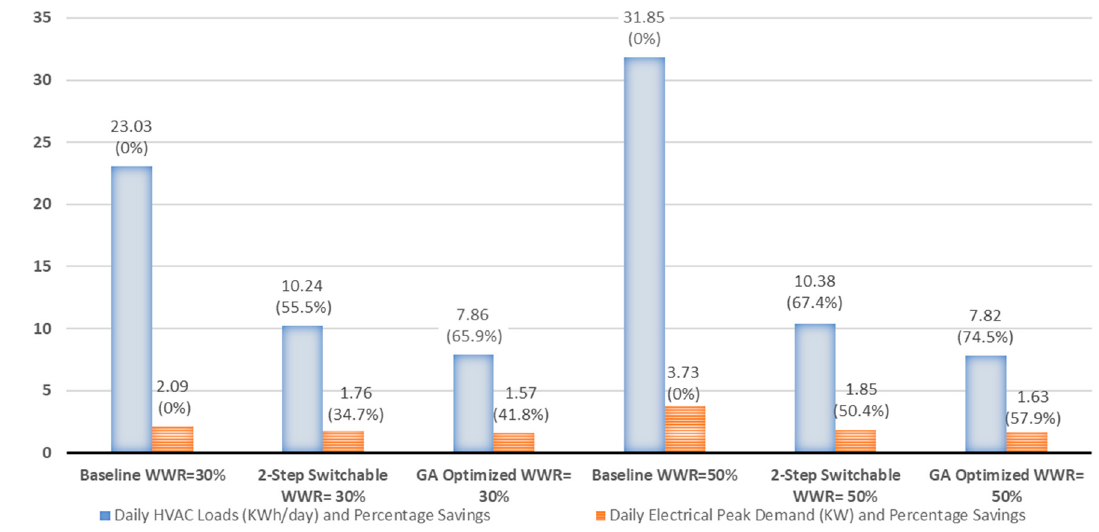
Figure 14. HVAC loads and electrical peak demand for baseline windows and STIS–smart windows applied to a house in Golden, CO, USA with WWR = 30% and WWR = 50%.